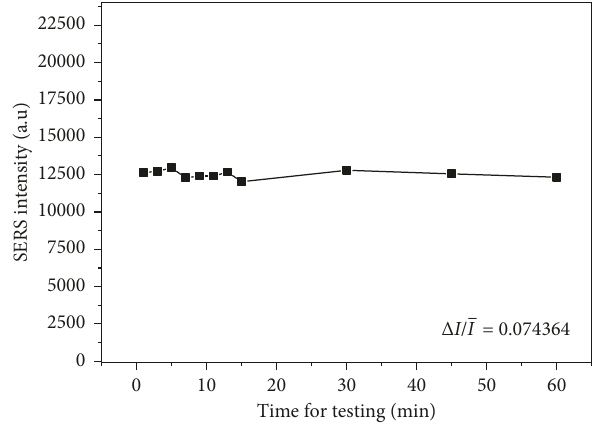
Figure 8: The relationship between the concentration of aspartame and the intensity of SERS characteristic peak.